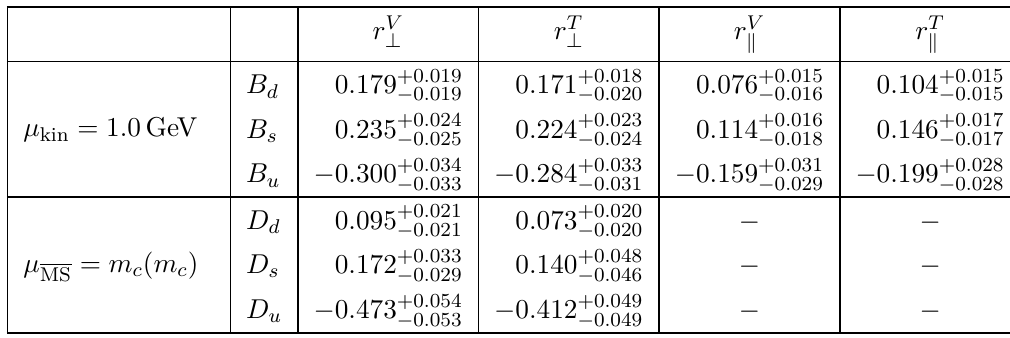
Table 6 . The residues (2.5), related to form factors, for the B - and D -mesons. The former are determined in the kinetic scheme and the latter in the MS